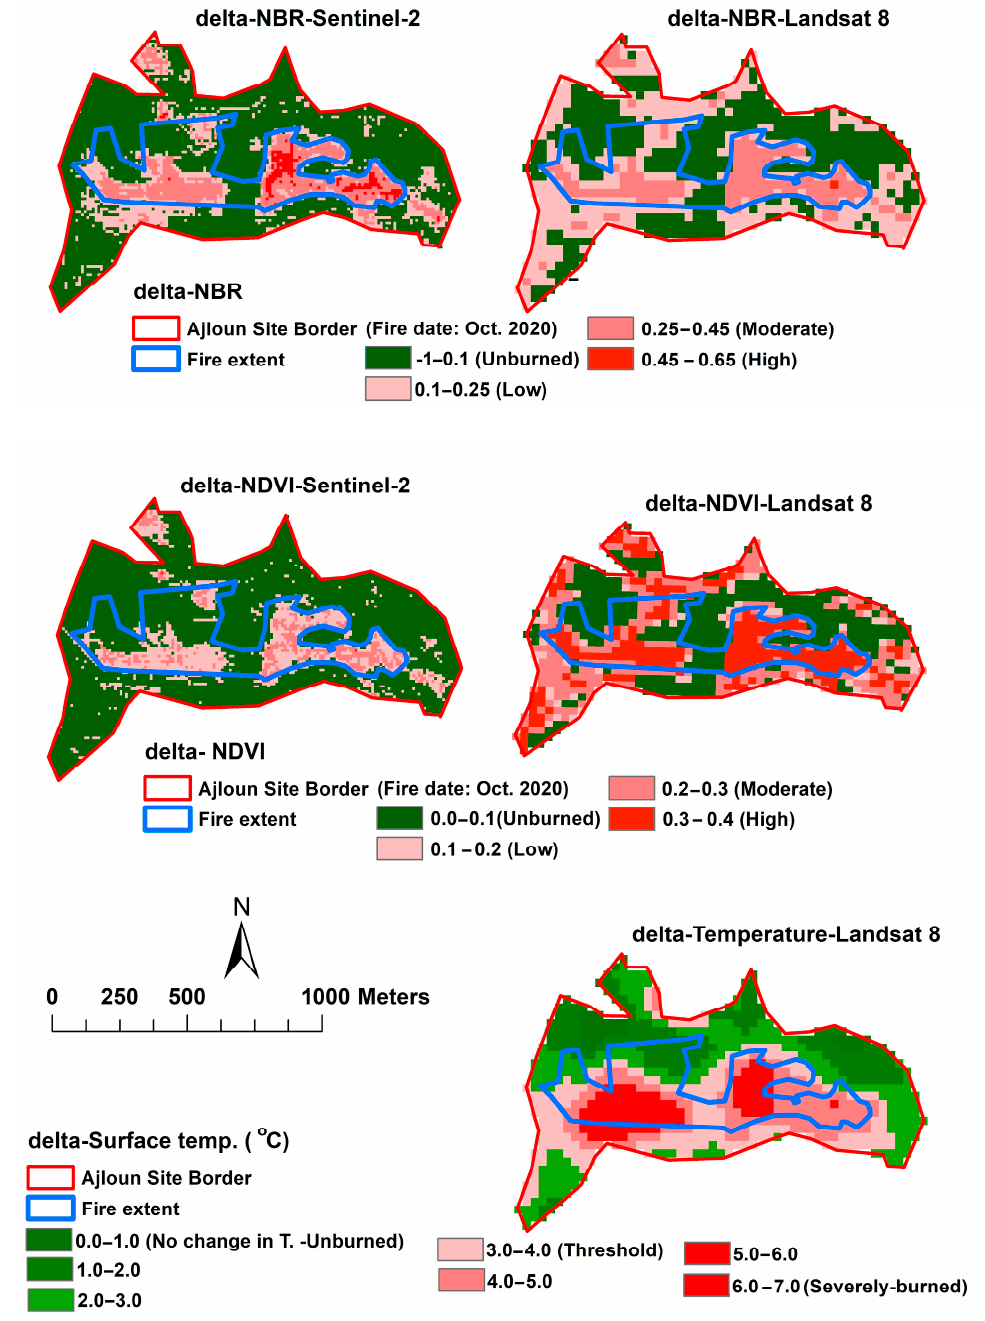
Figure 2. Landsat (OLI/ETM+) and Sentinel-2 (MSI) differenced Normalized Burn Ratio (dNBR), Normalized Different Vegetation Index (dNDVI) and thermal surface temperature (dTST) for Ajloun, Dibbeen and Sakeb wildfires, Northern